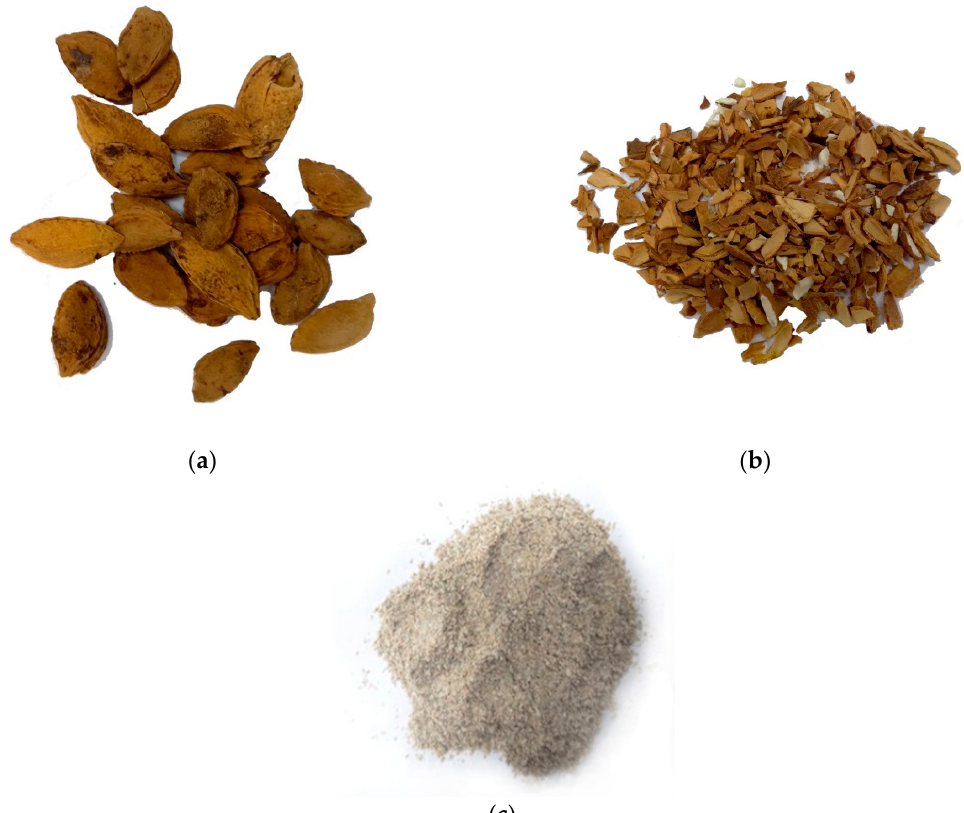
Figure 2. Plum stones, ( a ) as received from the processing plant and ( b ) in comminuted form for the granulation process; and ( c ) rye bran.